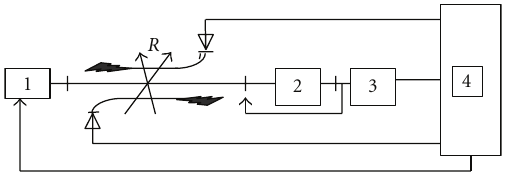
Figure 2: Scheme of the equipment for measuring the dielectric properties: 1: generators for the whole range: HP686A and G4-79 to 82; 2: frequency meters: H 532A; FS-54; 3: cavity resonator;